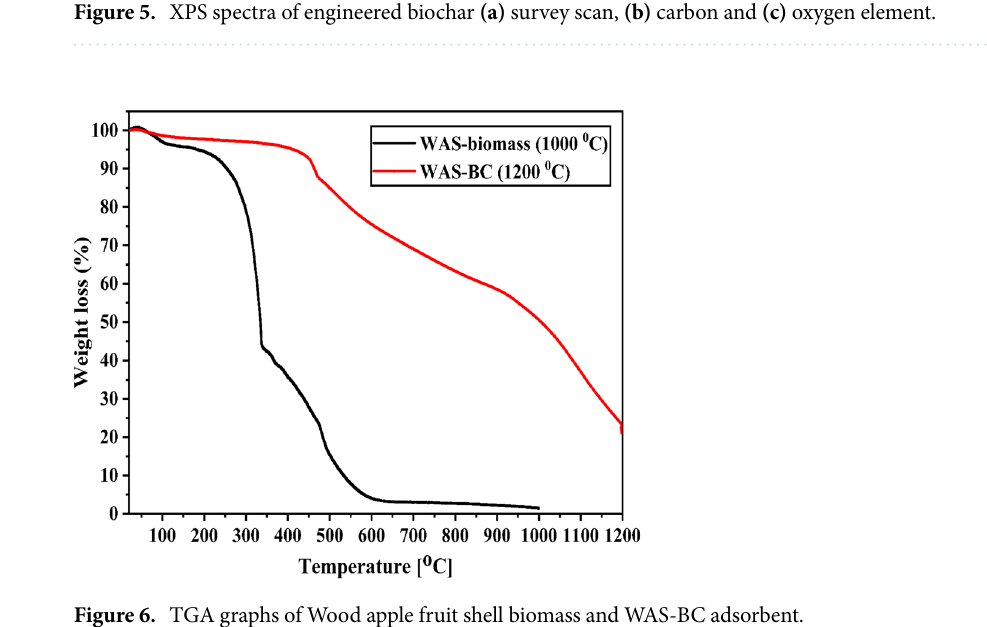
Figure 6. TGA graphs of Wood apple fruit shell biomass and WAS-BC